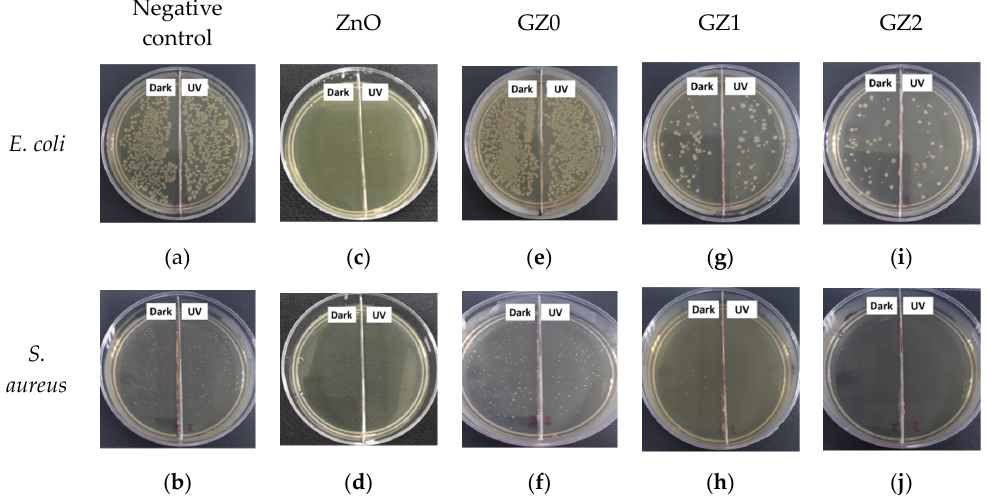
Figure 11. The photographs showing the antibacterial activity of ( a and b ) negative control, ( c and d ) ZnO particles, ( e and f ) GZ0, ( g and h ) GZ1 and ( i and j ) GZ2 against S. aureus and E. coli, respectively.